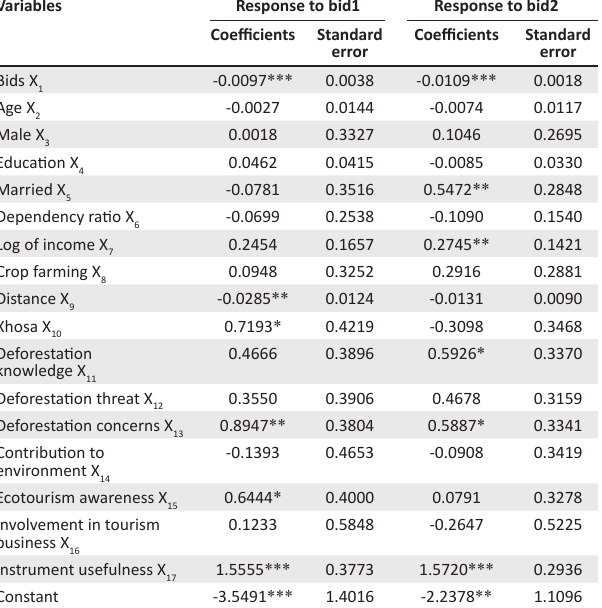
TABLE 7: Seemingly unrelated bivariate probit regression